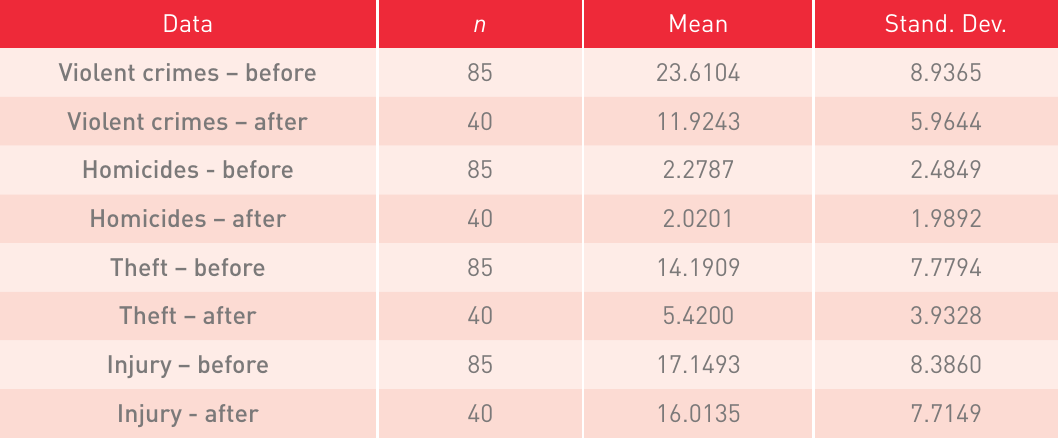
Descriptive Statistics for Brumadinho